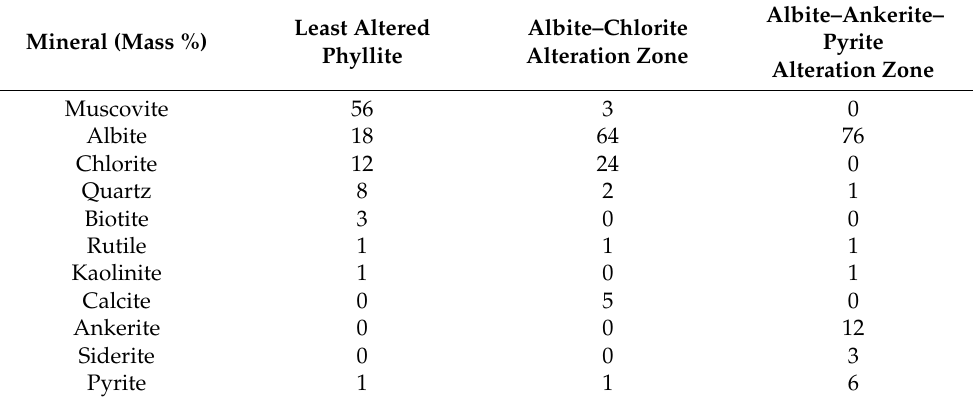
Table 2. Geochemical data of major oxides from different alteration zones measured by XRF.